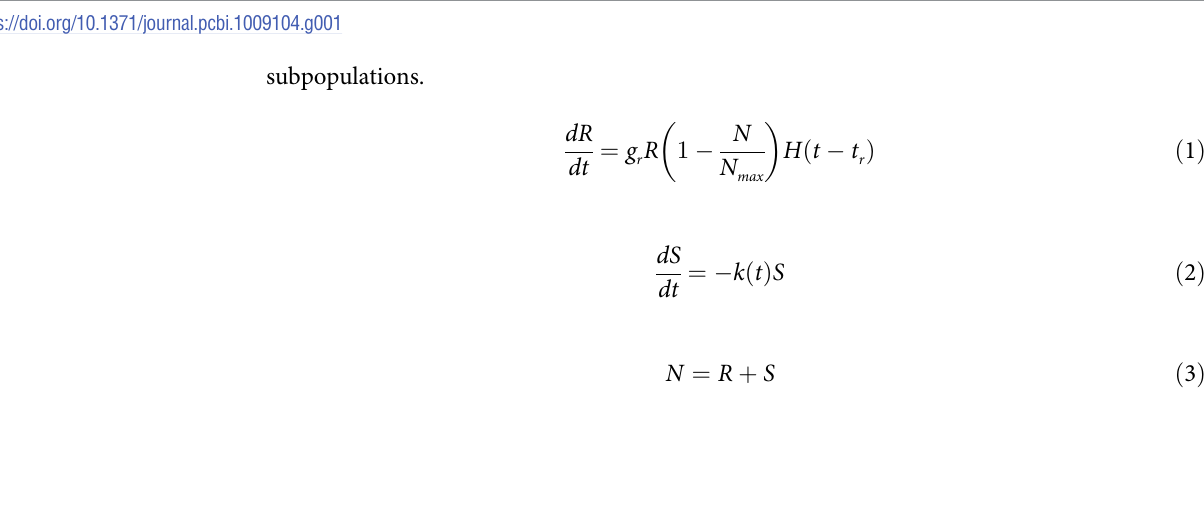
Fig 1. Schematic illustration of model structures with curves for total cell number (black) partitioned into resistant (red) and sensitive (green) fractions. Regions of the curves are marked to show the effects of key model parameters (A). The effects of three different models of k are shown for model 1 with an exponential time delay on k (B), model 2 with a linear time delay on k (C) or model 3 with no time delay on k